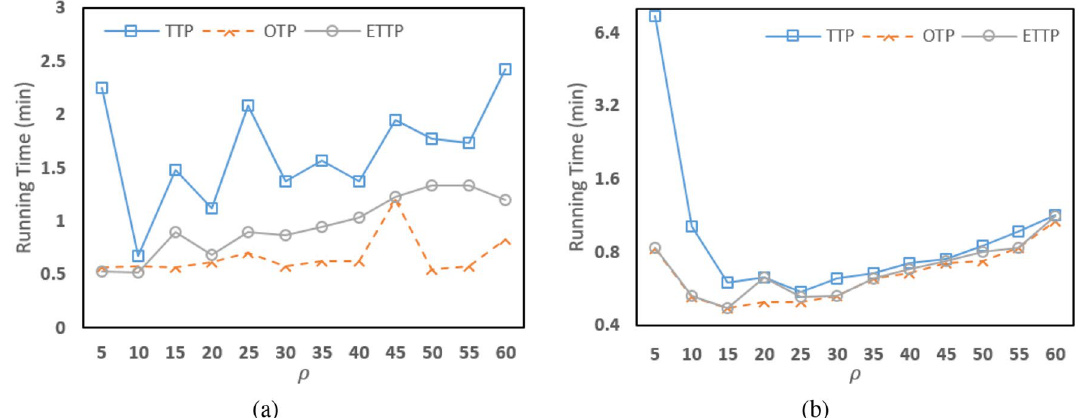
Figure 9. The running time of three algorithms in a multi-node with different ρ size on: ( a ) ca-HepTh dataset, and ( b ) wiki-Vote dataset.